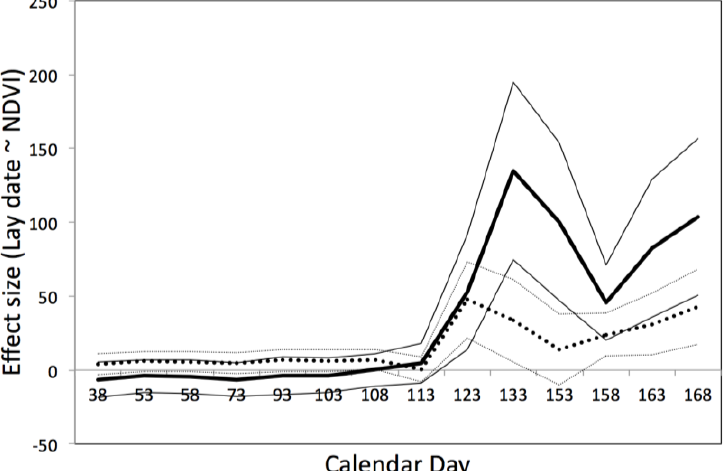
Figure 6. Regression coefficients (±SE) of the effect of NDVI on blue tit timing of reproduction (lay date) in 2013 ( n = 14 images, corresponding to 14 NDVI analyses). The effect of NDVI on lay date for all nestboxes where a reproductive event occurred in that year ( n = 53) is presented as a dashed thick black line (regression coefficient) and thin grey lines (standard errors). The effect of NDVI on lay date in nestboxes solely surrounded by deciduous oaks in a 50 m radius ( n = 27) is presented as a thick black line (regression coefficient) and thin black lines (standard